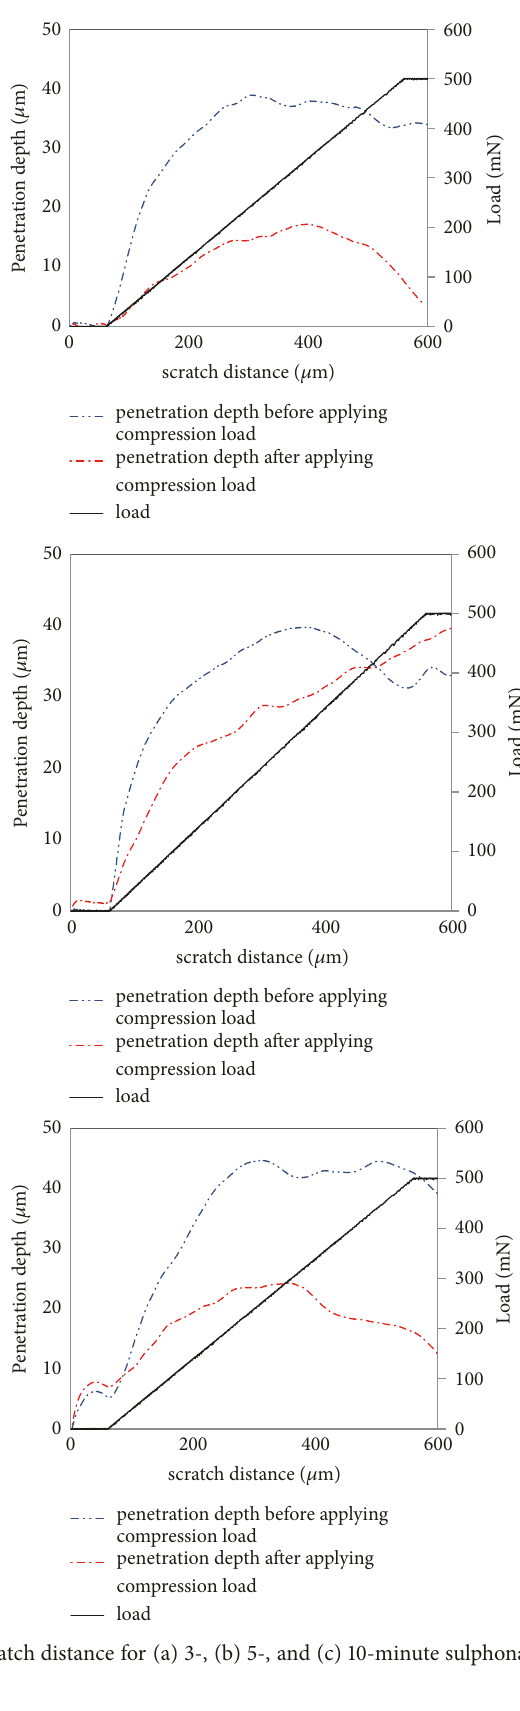
Figure 3: Penetration depth versus scratch distance for (a) 3-, (b) 5-, and (c) 10-minute sulphonation time without and with applying the compression